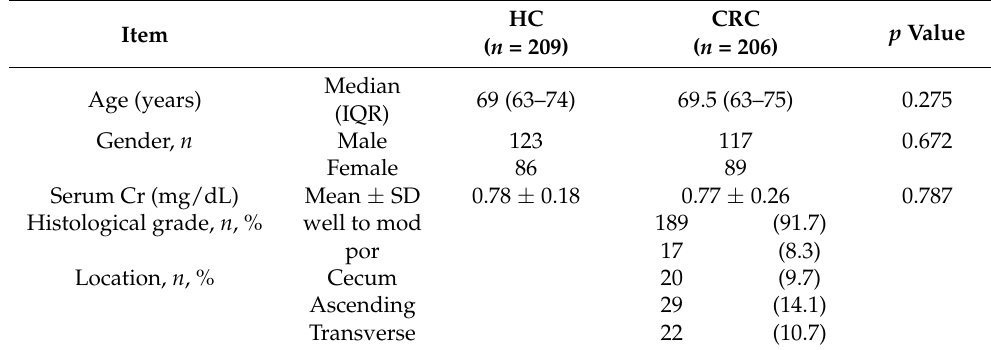
Figure 1. Study profile. HC, healthy control; CRC, colorectal cancer; qPCR, quantitative polymerase chain reaction. Table 1. Patient characteristics.